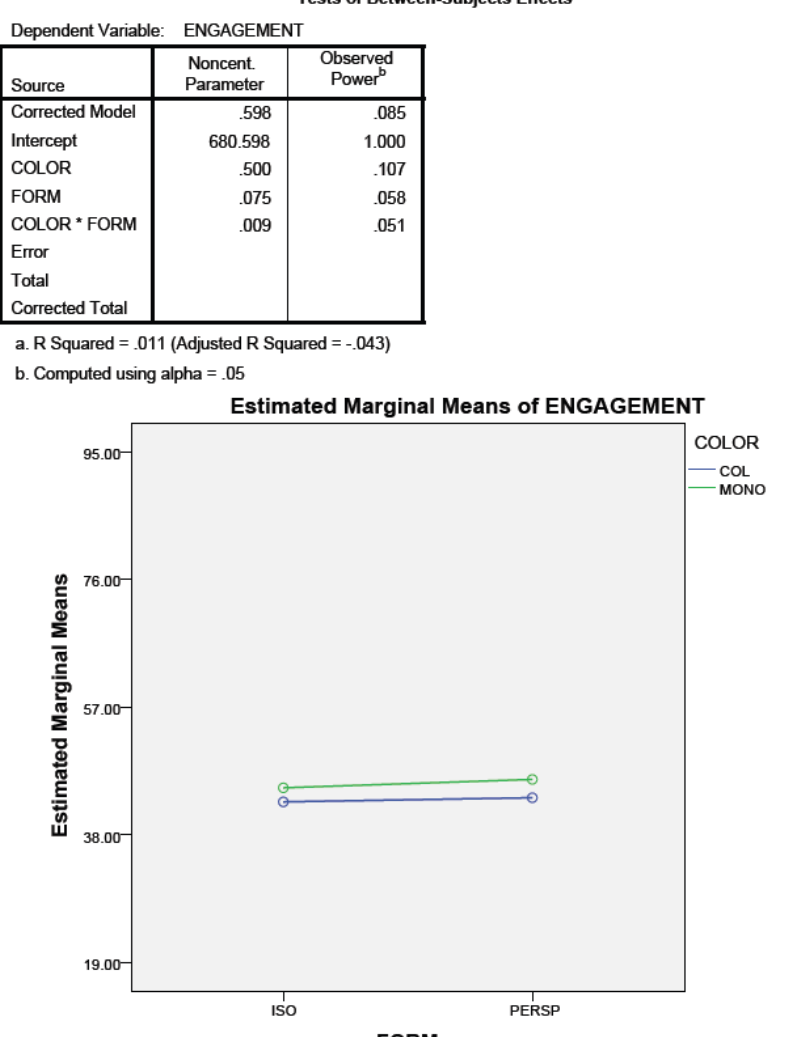
Figure B.8. ANOVA analysing engagement levels for the main and interaction effects of color and form using raw data for participants who correctly indicated their